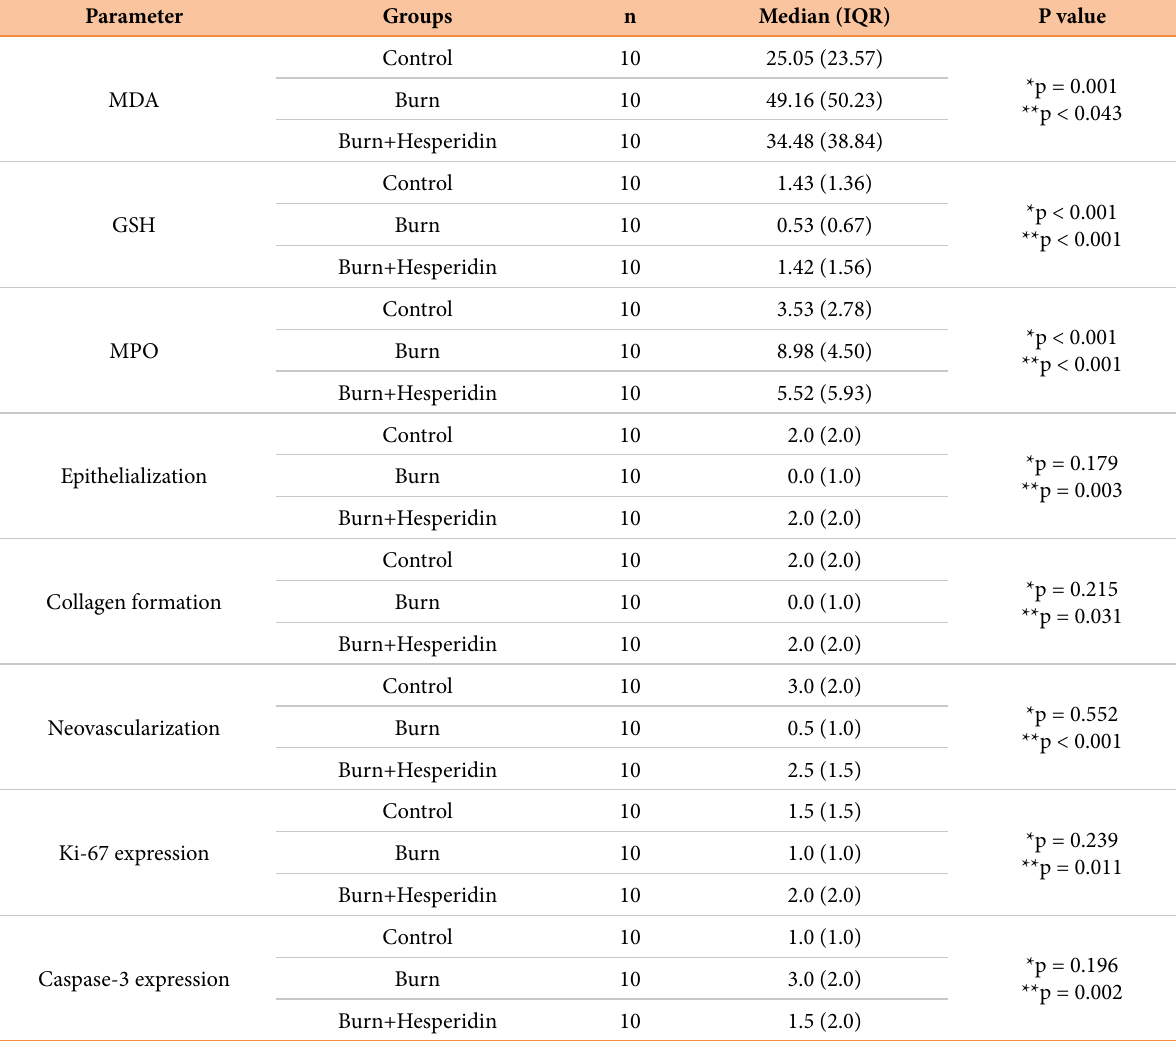
Table 1 – Biochemical and histological parameters of Control, Burn and Burn+Hesperidin